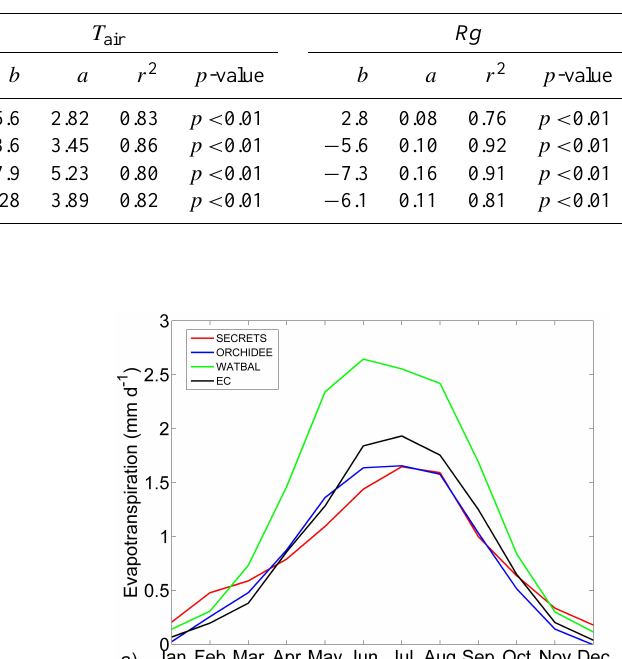
Table 2. Coefficients for the linear regression analyses between ET (based on monthly totals) estimated by the four different approaches (SECRETS, ORCHIDEE, WATBAL, eddy covariance [EC]) and the meteorological variables (i.e., mean monthly VPD; kPa, mean monthly air temperature [ T air ; Celsius] and monthly total global radiation [ Rg ; MJ m − 2 month − 1 ]) for each of the four methods. In all cases the model used was: y ( x )= a * x + b . Included in the table are estimates of the coefficient of determination ( r 2 ) and the p -values for each regression analysis.